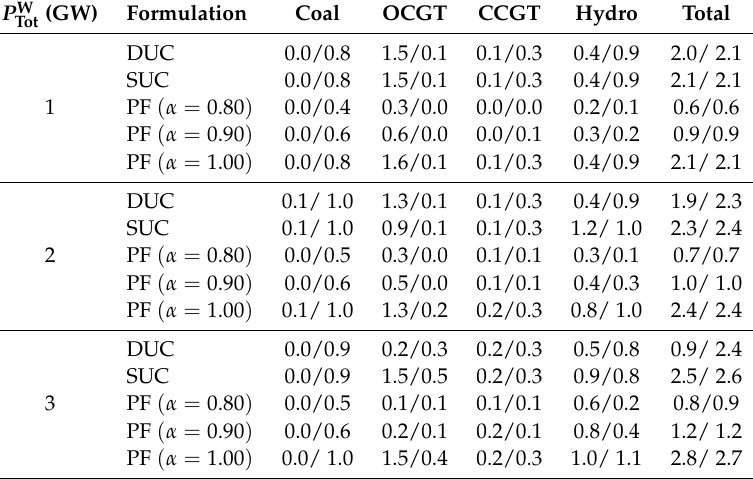
Table 6. Up/Down spinning reserve scheduling